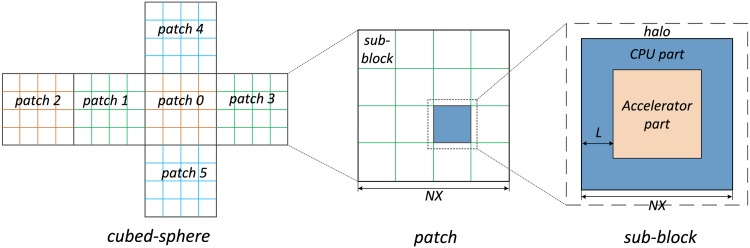
The three-layer partition scheme.